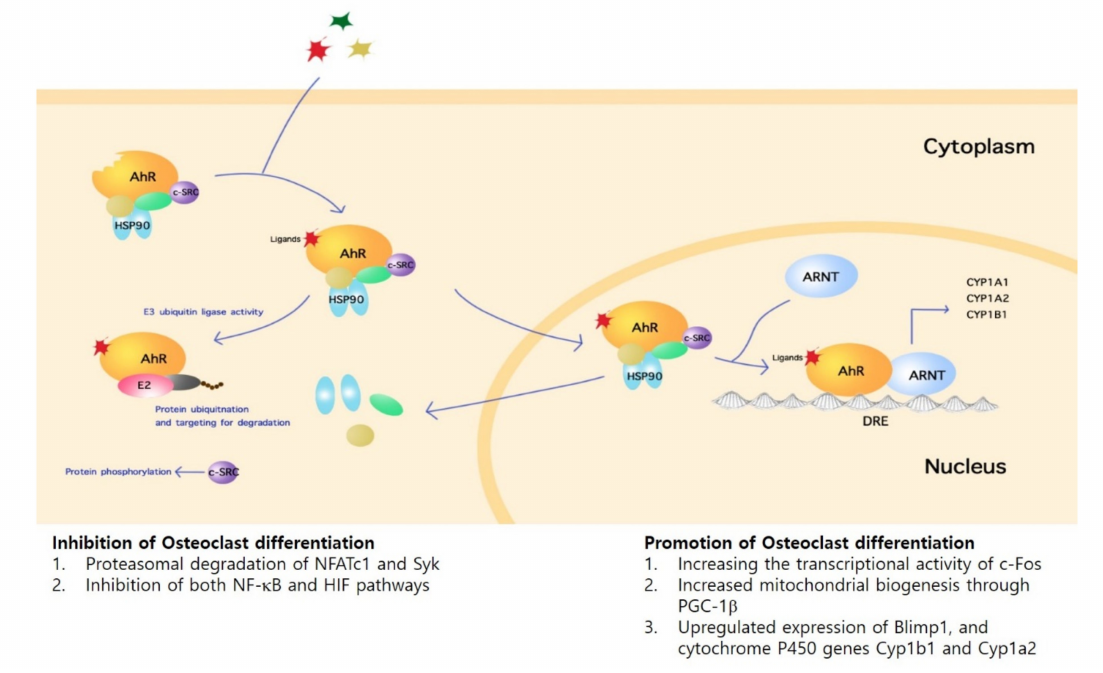
Figure 1. Aryl-hydrocarbon Receptor (AhR) Signaling Pathway in Osteoclasts. AhR is localized in the cytoplasm in multiprotein complex including c-src and HSP90. Interaction with an agonist results in translocation of the complex to the nucleus. In complex with AhR nuclear translocator (ARNT), AhR controls gene transcription by binding dioxin-response elements (DRE) / xenobiotic-responsive elements (XRE) containing genes. AhR signaling includes non-genomic pathways such as the release of c-src kinase with consequent target protein phosphorylation and AhR functioning as an E3 ubiquitin ligase. Such intracellular signaling mechanisms lead to either the activation or inhibition of osteoclast di ff erentiation and